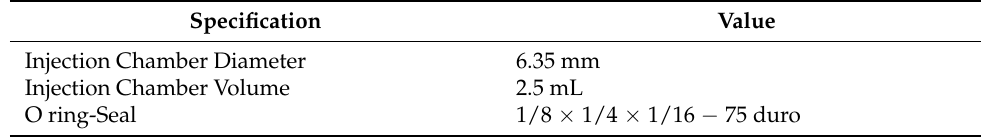
Table 5. Servo-Tube Injector Specifications.